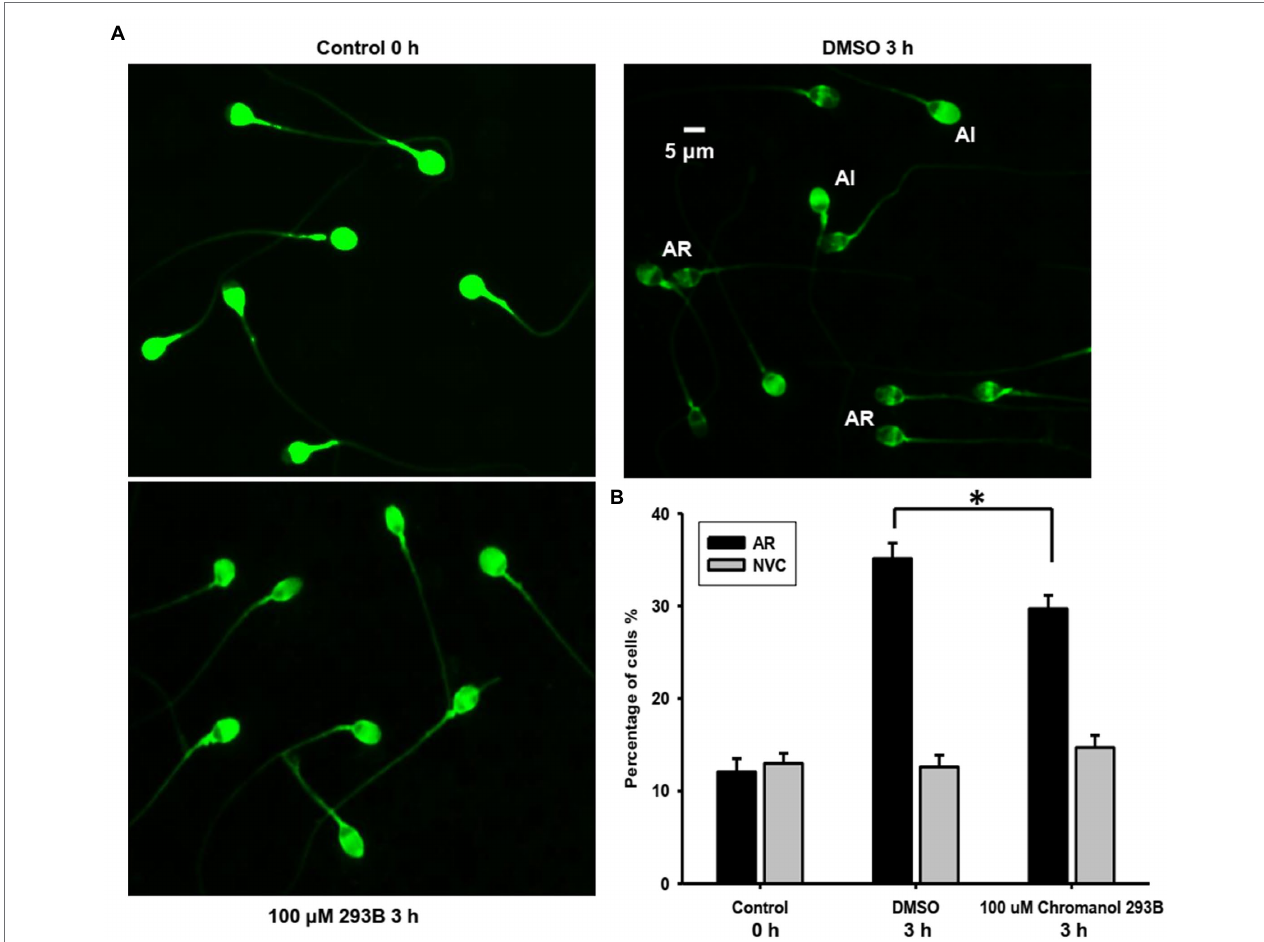
FIGURE 2 | Chromanol 293B effect on human sperm AR and viability. (A) The human sperm AR was evaluated using PSA-FITC staining. Sperm were treated with different reagents (DMSO or 100 μ M chromanol 293B) for 3 h during capacitation, and the sperm were then treated with 15 μ M progesterone for 15 min to induce AR. To detect spontaneous AR before capacitation, sperm were stained with PSA-FITC immediately after discontinuous Percoll gradient centrifugation and washing. AR indicates acrosome-reacted sperm, while acrosome integrity (AI) indicates uncapacitated sperm. (B) After PSA-FITC staining, sperm were examined by fluorescence microscopy. The AR ratio is calculated by dividing the number of AR sperm with the total number of sperm. For 100 μ M chromanol 293B group compared to vehicle control group, * p < 0.05. Propidium iodide (PI) is used to stain dead sperm. Percentage of not viable cells (NVC%) was calculated. Values represent the means ± SEM of at least 6